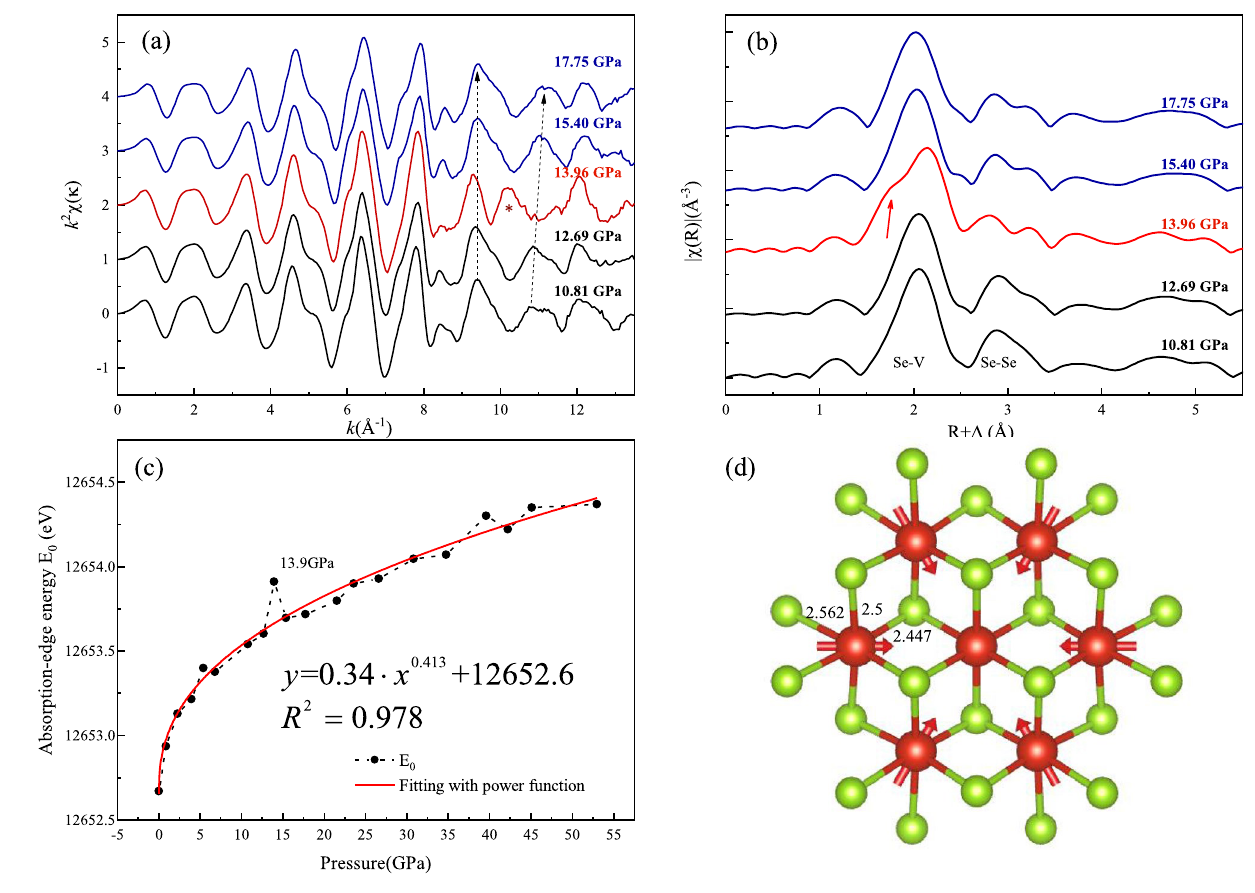
Figure 3. ( a ) The Se K -edge EXAFS k 2 χ ( k ) oscillation signals from 10.81GPa to 17.75GPa. Abnormal oscillation signals are marked by the red asterisk. ( b ) The corresponding Fourier-transformed magnitude with Se-V and Se-Se bond marked. ( c ) Experimental data (black solid dots) and curve fitting (red line) of the pressure dependence of absorption edge energy in VSe 2 . ( d ) The calculated real space displacement pattern of the 2D-CDW state. The displacement of V atoms across the 1T -CDW transition is marked by the red arrow, the splitting of Se-V bond length is also shown.